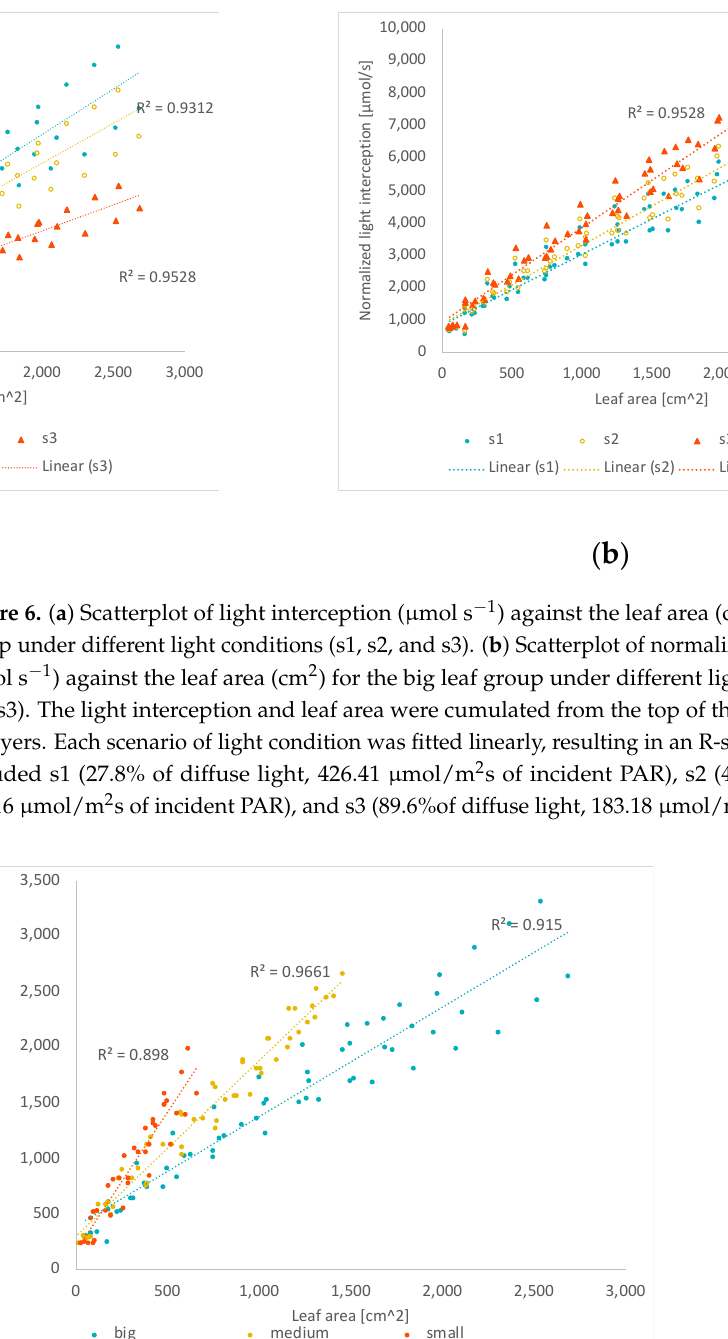
8 of 18 sn3 was 34.4% more than sn1. The ratio of diffuse light of sn1 was lower than sn3, as indicated by the line according to the y-axis on the right in Figure 5c. This indicated that the light interception was influenced by both the amount of incident radiation and ratio of diffuse light. The amount of incident radiation, however, outperformed the amount of diffuse light ratio due to an increased light interception of 26.8% in s1 more than s3, with 56.8% increased radiation and 226.1% reduced diffuse light. 3.2. The Light Interception versus Leaf Area